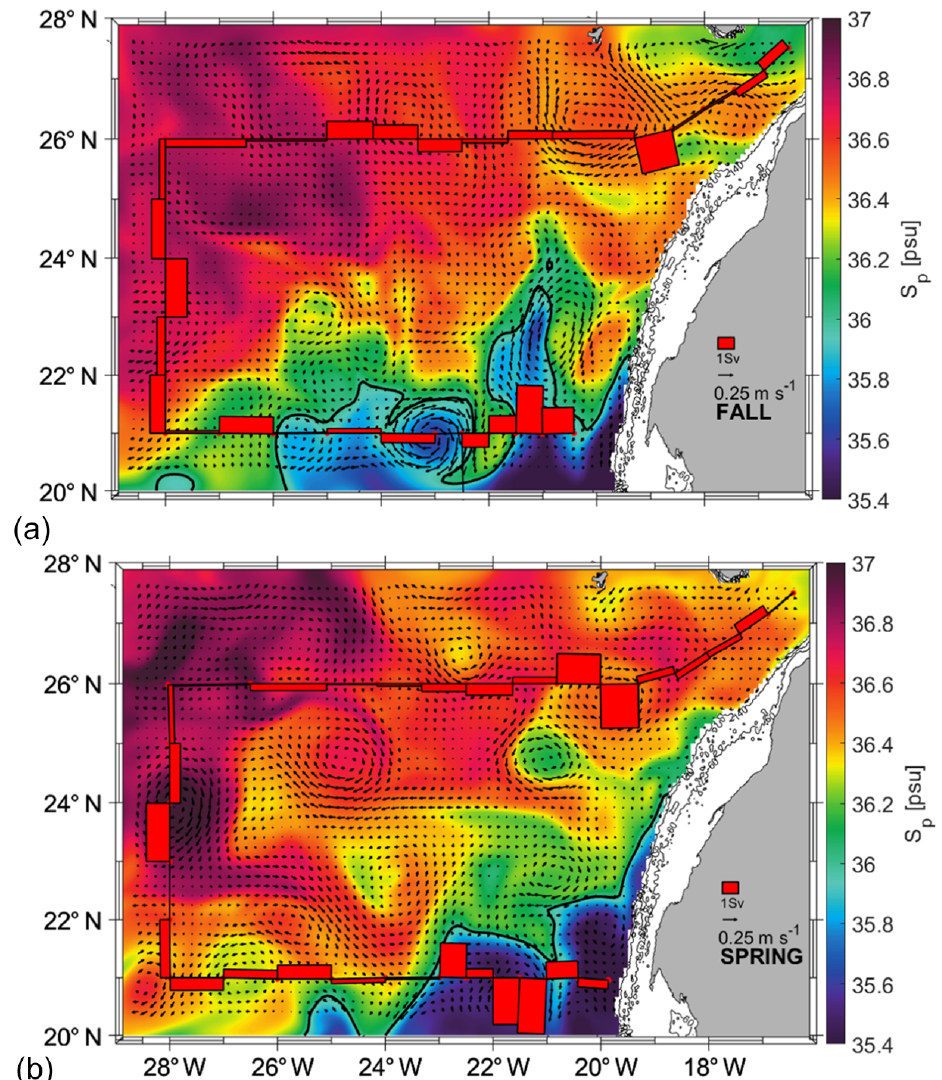
Figure 15. Mean salinity and mean geostrophic velocity at 156m extracted from GLORYS during fall (b) and spring (b) . The black line indicates the position of isohaline 36 at this depth, used to identify the CVFZ. The red bars represent mass transports in the shallowest layer as estimated by the inverse